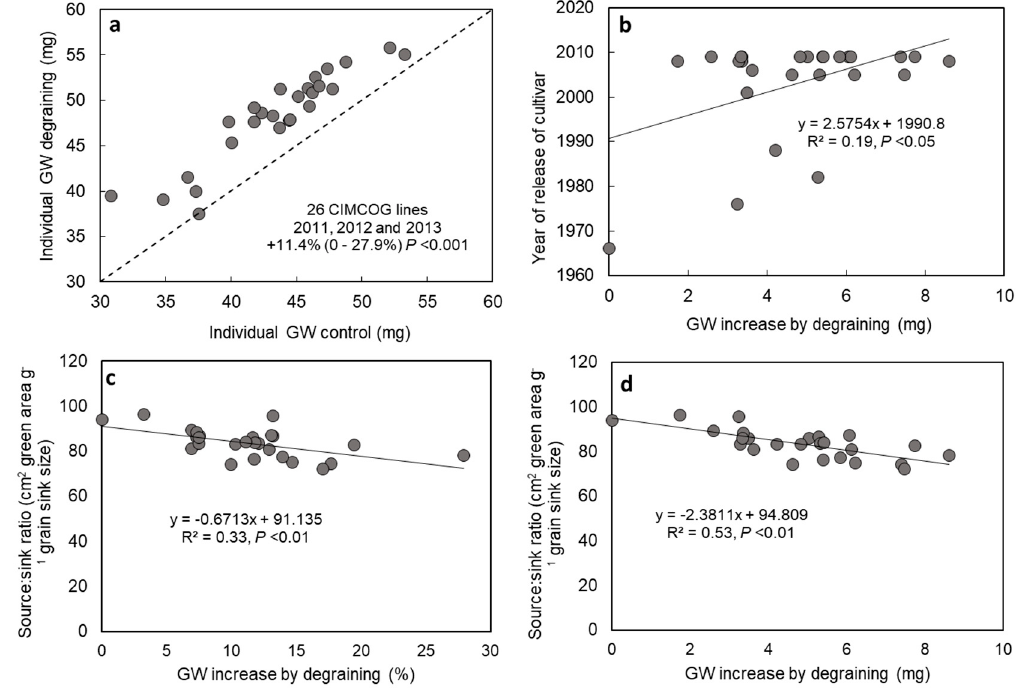
Figure 2. ( a ) Grain weight (GW) in control shoots versus GW in degrained shoots; ( b ) GW increase by degraining relative to the control (mg) versus the year of release of cultivars; ( c ) source–sink ratio (cm 2 green area g − 1 grain sink size) versus ( c ) GW increase by degraining relative to control (%) and ( d ) versus GW increase by degraining relative to control (mg). The dashed line in ( a ) represents the 1:1 ratio. All data are means of 2011, 2012 and 2013 for the 26 CIMCOG cultivars.